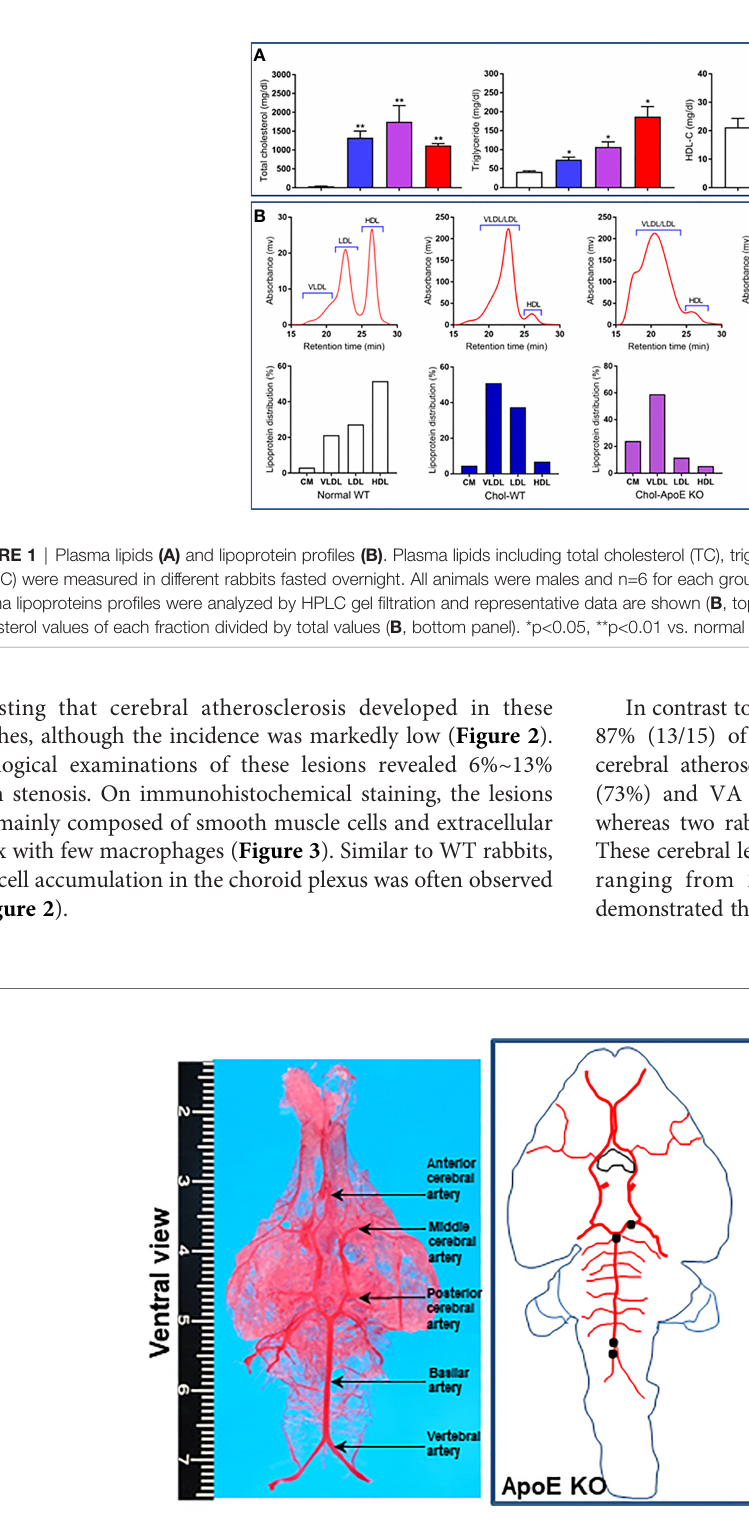
FIGURE 2 | Vascular casting of cerebral arteries (left) and schematic mapping of the distribution of all intracranial atherosclerosis in all sections (12 sections/each animal) of apoE KO (n=12) and WHHL rabbits (n=15)(right). Hematoxylin-eosin stained-sections were used to observe the arteries with lesions. Each spot indicates one lesion site detected under the light microscopic observations. All lesions were distributed in PCA, BA, and